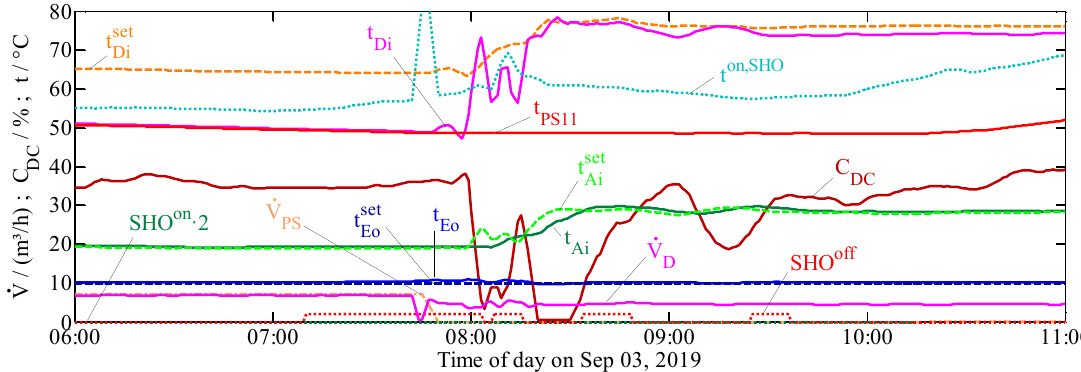
Figure 8. Shutdown of solar heat operation with the improved control strategy.